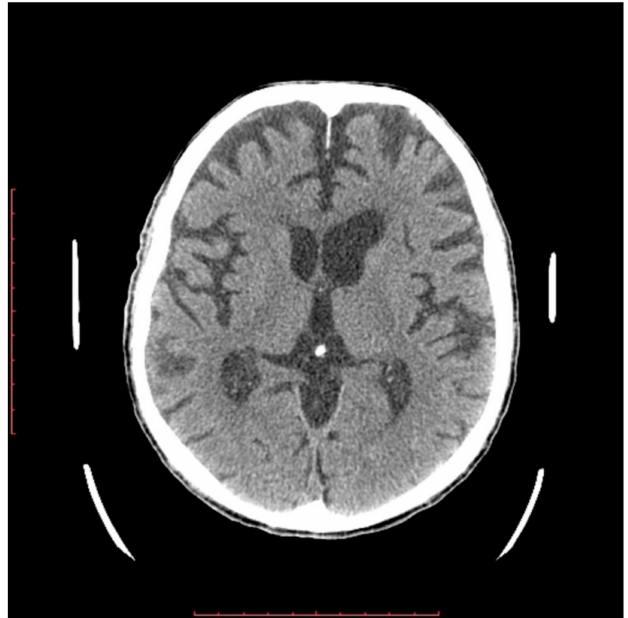
Figure 2. Computed tomography (CT) examination made before patient’s death. Progression of frontal lobe and subcortical atrophy with secondary ventricular dilatation are